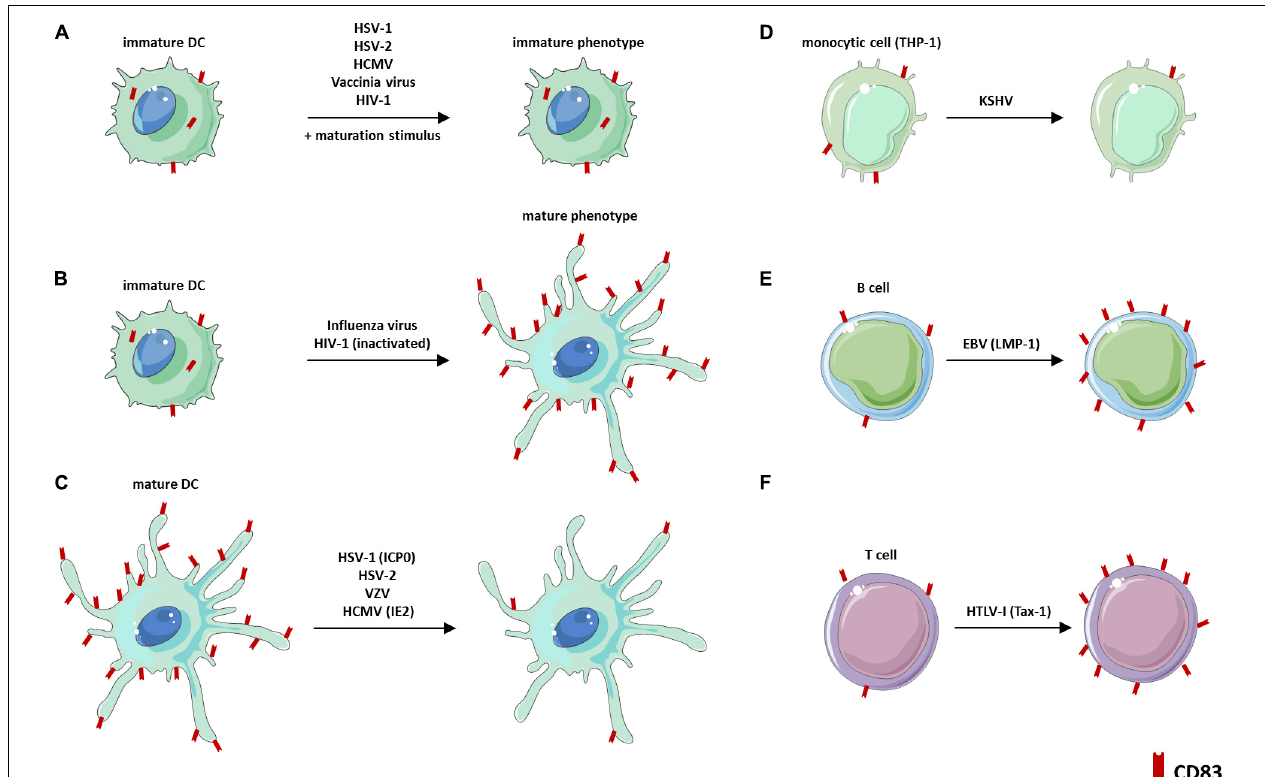
FIGURE 4 | Virus-induced modulations of CD83 expression. (A) Viruses that block DC maturation and thus CD83 expression. (B) Viruses that induce CD83 expression via activation of a mature DC phenotype. (C) Viruses that mediate a downregulation of CD83 expression on mature DCs. (D) Reduction of CD83 surface expression during latent KSHV infection of THP-1 cells. (E) Induction of CD83 expression on B cells via EBV-encoded LMP-1. (F) Induction of CD83 expression via HTLV-1-encoded Tax-1. DC: dendritic cell, EBV: Epstein-Barr Virus, HIV-1: Human immunodeficiency virus-1, HCMV: Human cytomegalovirus, HSV-1: